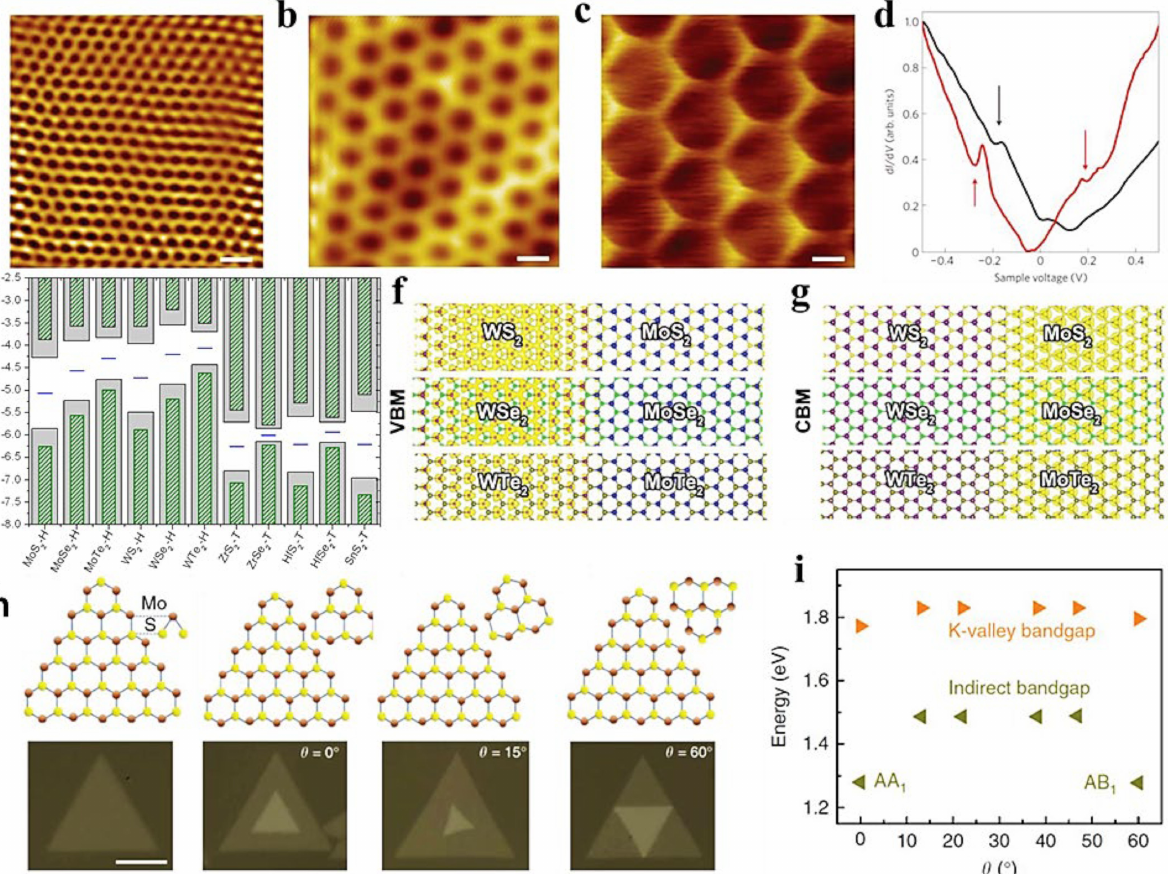
Figure 5. STM topographical photographs at ( a ) 2.4 nm, ( b ) 6.0 nm, and ( c ) 11.5 nm, ( d ) The arrows in the experimental dI/dV curves stipulate the dips at two different moir é wavelengths, 9.0nm (black) and 13.4nm (red). The black curve shows a dip energy of 0.28 eV, whereas the red curve shows a dip energy of 0.22 eV from the Dirac point respectively. Further, the valence band exhibits much deeper dips than the conduction band, which indicates different relative strengths. Adapted with permission from Ref. [79]. Copyright 2012, Nature Publishing Group. ( e ) Visualization of band alignment for monolayer semiconducting TMDs as well as monolayer SnS 2 . Adapted with permission from Ref. [104]. Copyright 2013, American Institute of Physics. ( f ) VB maximum and ( g ) CB minimum charge densities in monolayer WX 2 /MoX 2 (X = S, Se, and Te) lateral heterostructures with similar X sites. Adapted with permission from Ref. [102]. Copyright 2013, American Institute of Physics. ( h ) Optical photographs of mono- and bilayer MoS 2 at certain twisting angles. ( i ) Display of energy values evaluated from Kohn–Sham K-valley indirect bandgaps (green) and direct bandgaps (orange). Adapted with permission from Ref. [105]. Copyright 2014, Nature Publishing